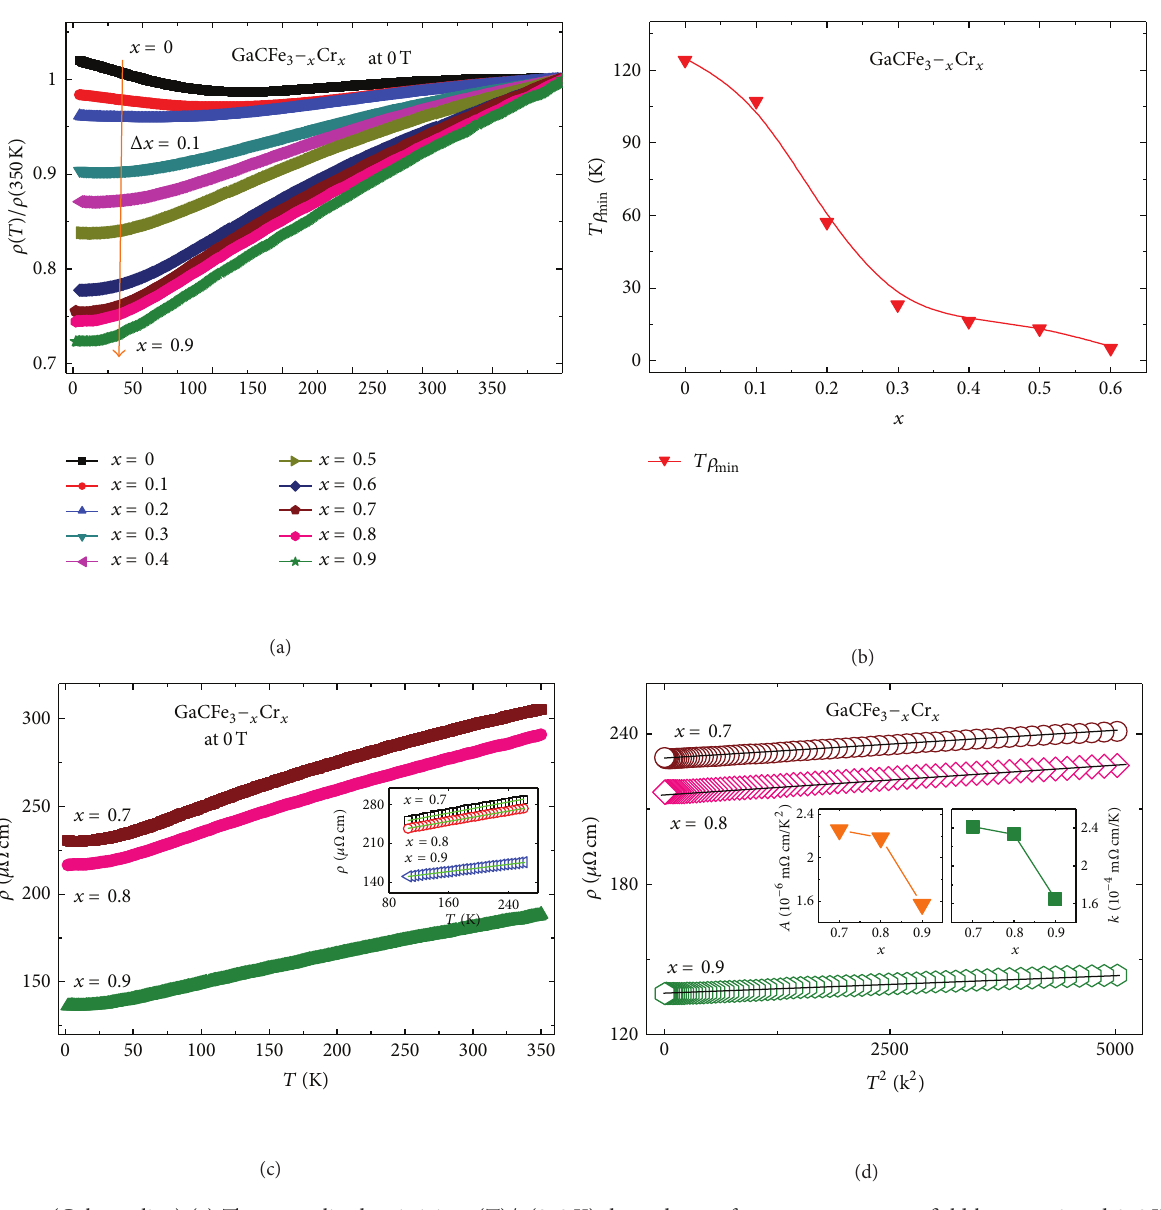
F 5: (Color online) (a) e normalized resistivity K) dependence of temperature at zero �eld between 2 and 350K for for the samples with dependence of resistivity at zero ma�netic �eld for GaCFe ); inset displays the linear �ts of 𝜌𝜌𝜌𝜌𝜌𝜌𝜌𝜌𝜌𝜌𝜌𝜌𝜌 for the samples with ; the le and between 100 and 270K. (d) e lower- T data plotted as versus ri�ht insets show �tted parameters and as a function of , respectively (see text for details). 𝜌𝜌𝜌𝜌𝜌𝜌 2 𝜌𝑥7 ≤ 𝑥𝑥 ≤ 𝜌𝑥𝑥 𝜌𝑥7 ≤ 𝑥𝑥 ≤ 𝜌𝑥𝑥 𝜌𝜌𝜌𝜌𝜌𝜌 𝜌𝜌𝜌𝜌𝜌𝜌 𝜌𝜌 𝐴𝐴 𝑘𝑘 𝑥𝑥 T 1: e �ttin� parameters